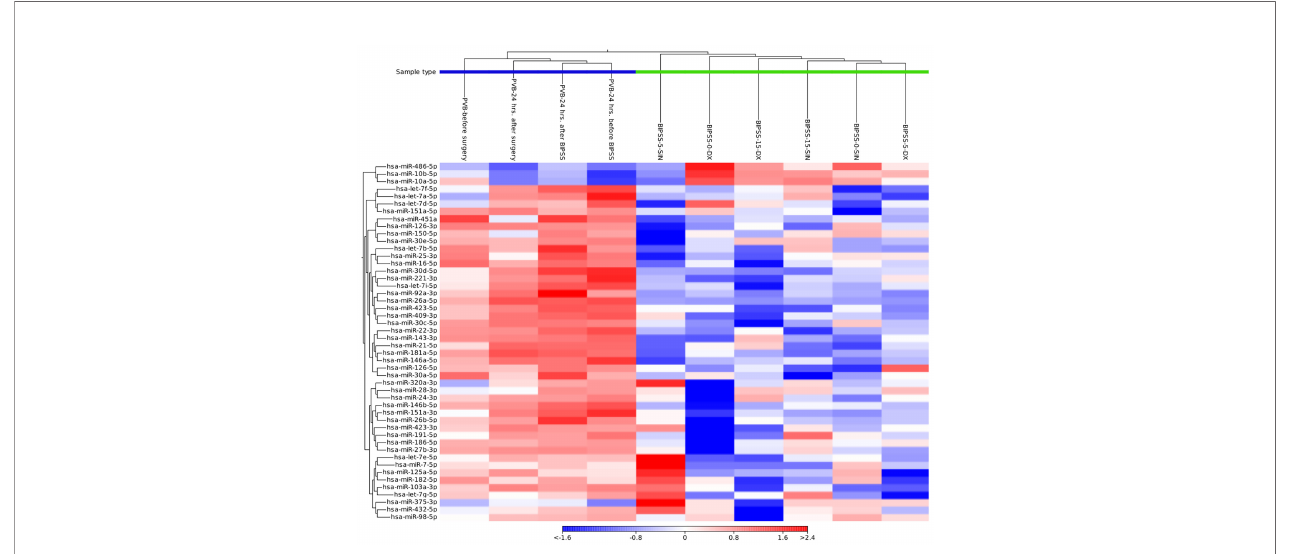
FIGURE 3 | Heat map containing expression patterns of miRNAs to differentiate plasma collected from BIPSS vs PVB. The heat map was generated by selecting a fi xed number offeatures (50) with the highest coef fi cient of variation and with a minimum supporting count of 1000 reads. Distance measure - Euclidean distance. Cluster analysis showed that there is a clear difference in the expression of miRNAs between BIPSS and PVB